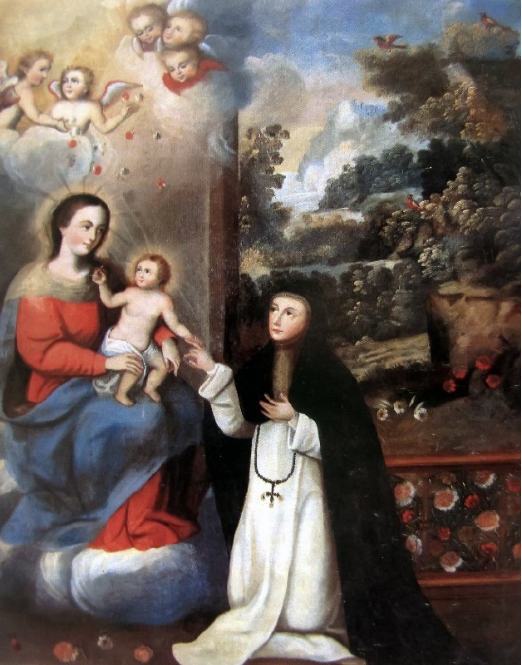
Figure 9. Unidentified artist, Mystic Nuptials of Saint Rose of Lima , 18th century, oil on canvas. Mon- asterio de Santa Rosa, Lima. Monasterio de Santa Rosa,